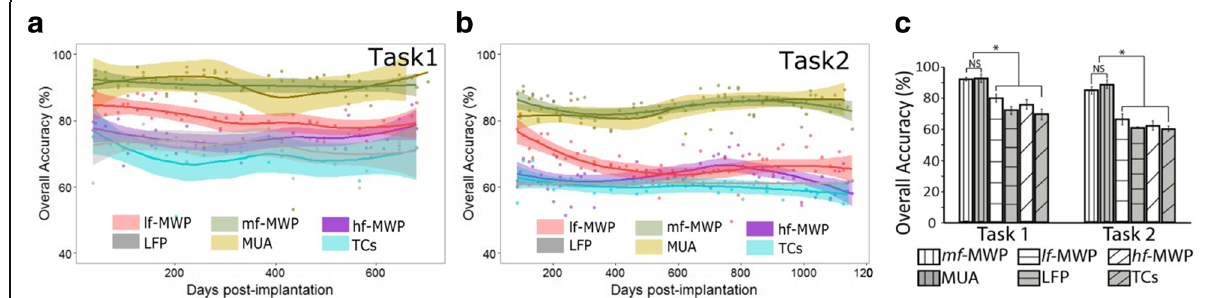
Fig. 8 Overall classification accuracy of the decoder output when using different features as input across the entire study. a , b Each data point shows the overall accuracy from an experimental day, and the line is the LOESS regression of all the discrete data points across time. In Task 1 and Task 2, using mf -MWP and MUA features as input, it consistently generated the highest overall accuracy throughout the entire phase of the study (Statistical analysis indicates difference between the two overall accuracy time series were non-significant). c The averaged overall accuracy of the study was significantly higher (* indicates p < 0.001, n = 62 in Task1, and n = 64 in Task2) when using mf -MWP and MUA as input into the decoders, compared to those using lf -MWP, hf -MWP, LFP or TCs features as decoder input. Each error bar shows the standard deviation of the